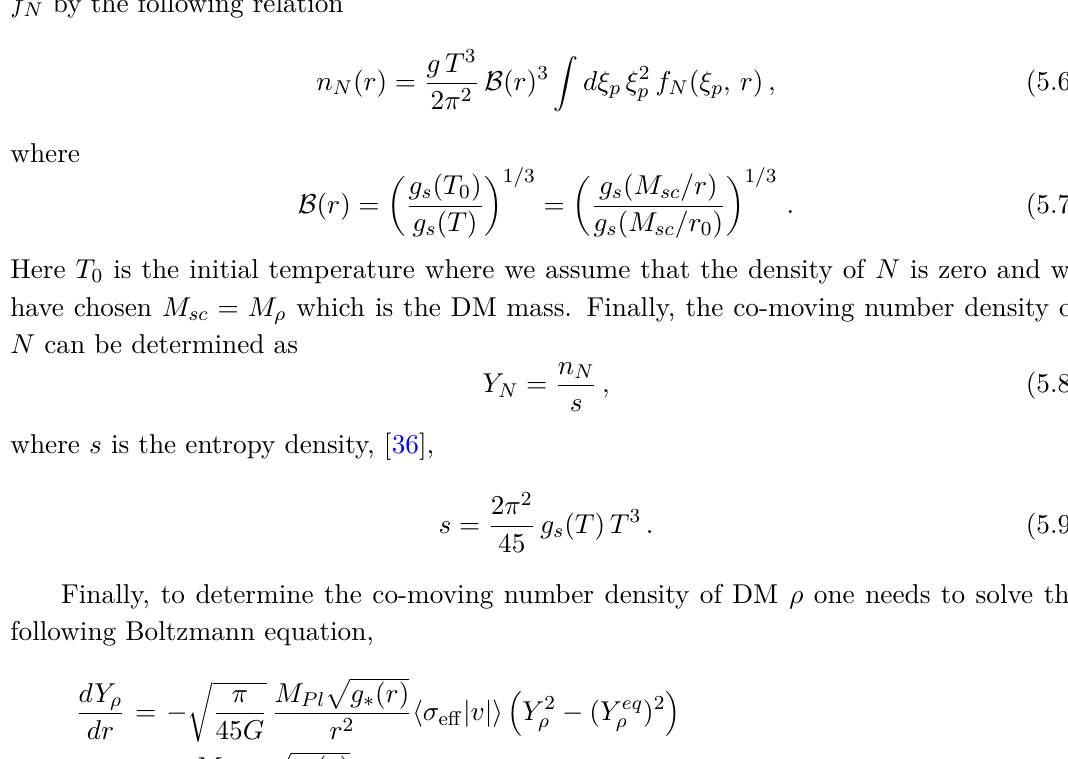
be solved numerically. The number density of N is obtained from the distribution function by the following f N